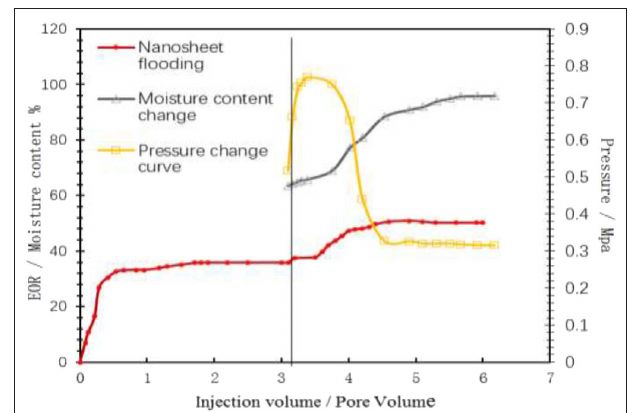
FIGURE 11 | Oil displacement dynamic curve of